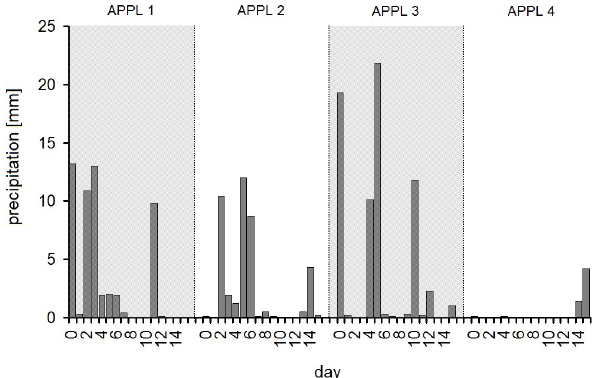
Figure 1. Daily sums of precipitation following the organic fertil- izer application events